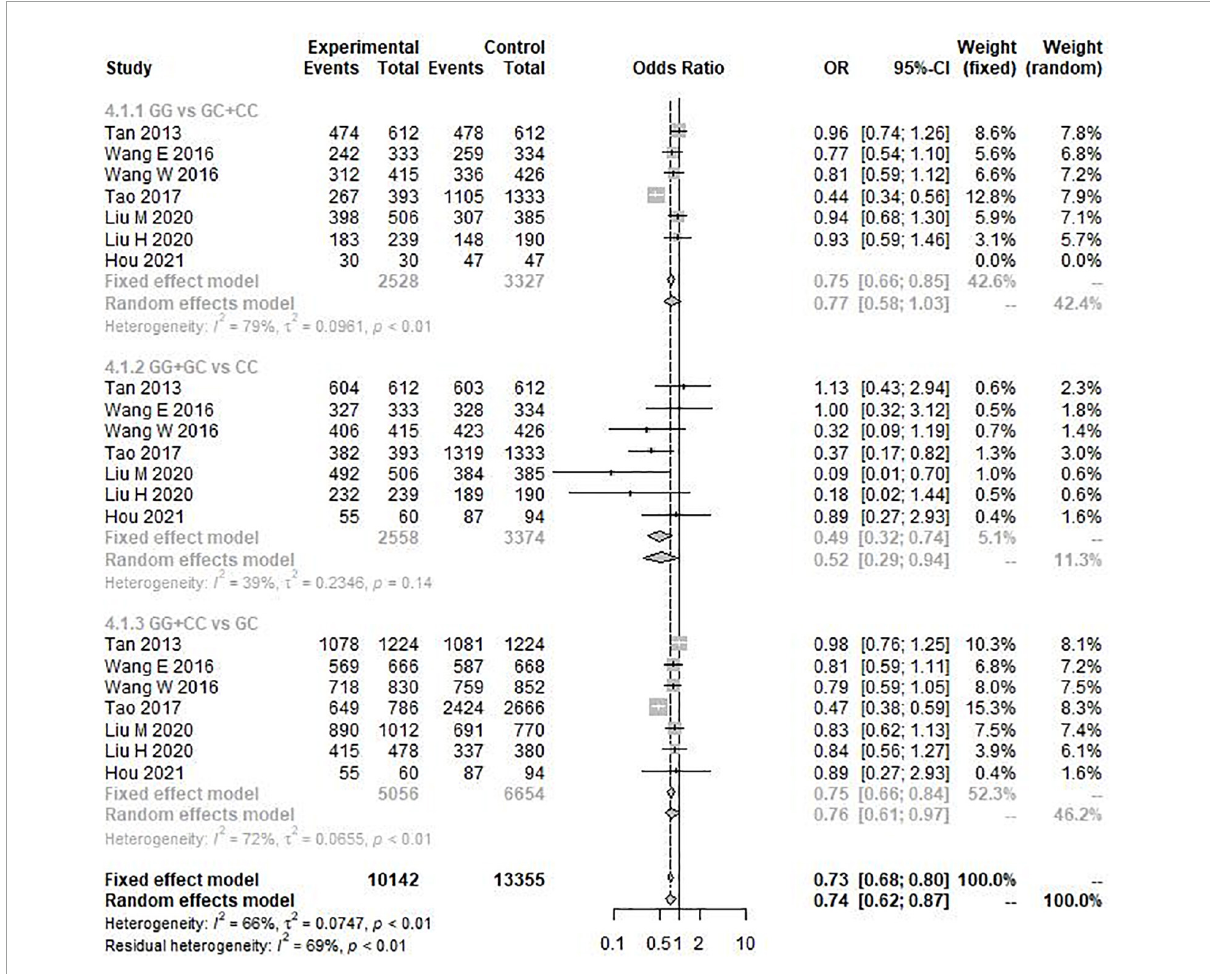
FIGURE3 Forest plot for the meta-analysis of the rs9349407 polymorphism using the recessive, dominant, and additive models.